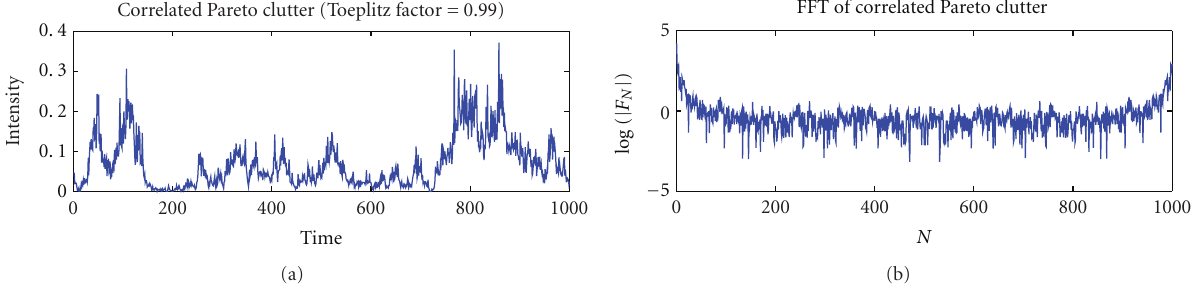
Figure 2: Correlated Pareto clutter, where the correlation is